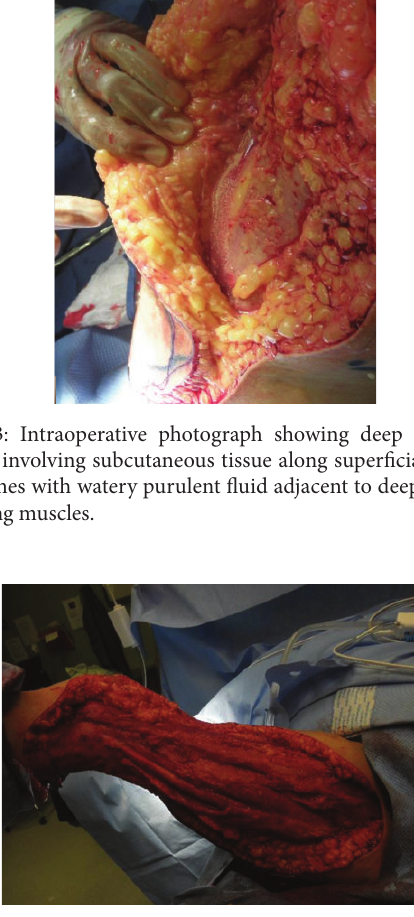
Figure 4: Intraoperative photograph showing aggressive surgical debridement of all necrotic and infected tissues involving the right